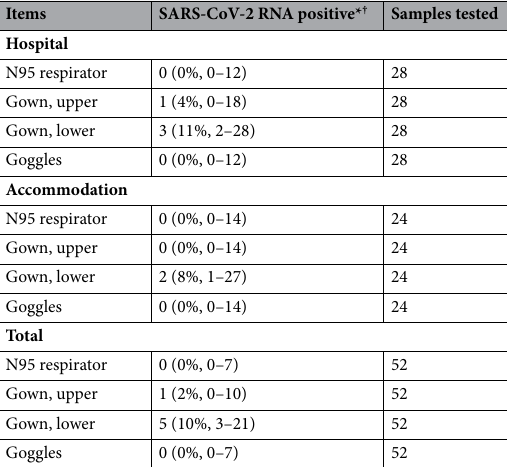
Table 5. SARS-CoV-2 test results of personal protective equipment after changing the linens. *All Ct values detected were ≥ 37, and the viral isolation result was negative. † The number of positive samples (percentage of positive samples, 95% confidence intervals for the